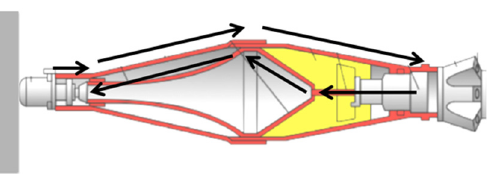
Figure 3. The flow of the current through the detonation chain upon the impact of the piezoelectric element on a hard surface.